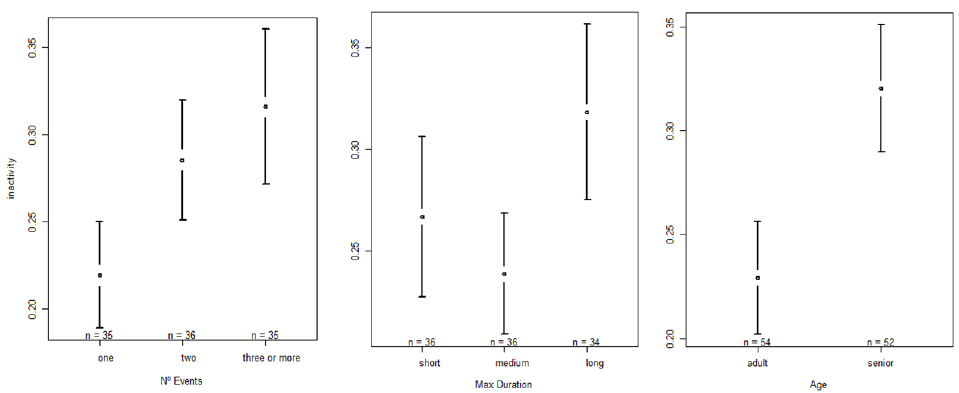
Figure 1. Confidence interval plots of inactivity behavior and the three significant fixed effects: num- ber of sound events at night (N° events), duration of the longest event (max duration), and age category.